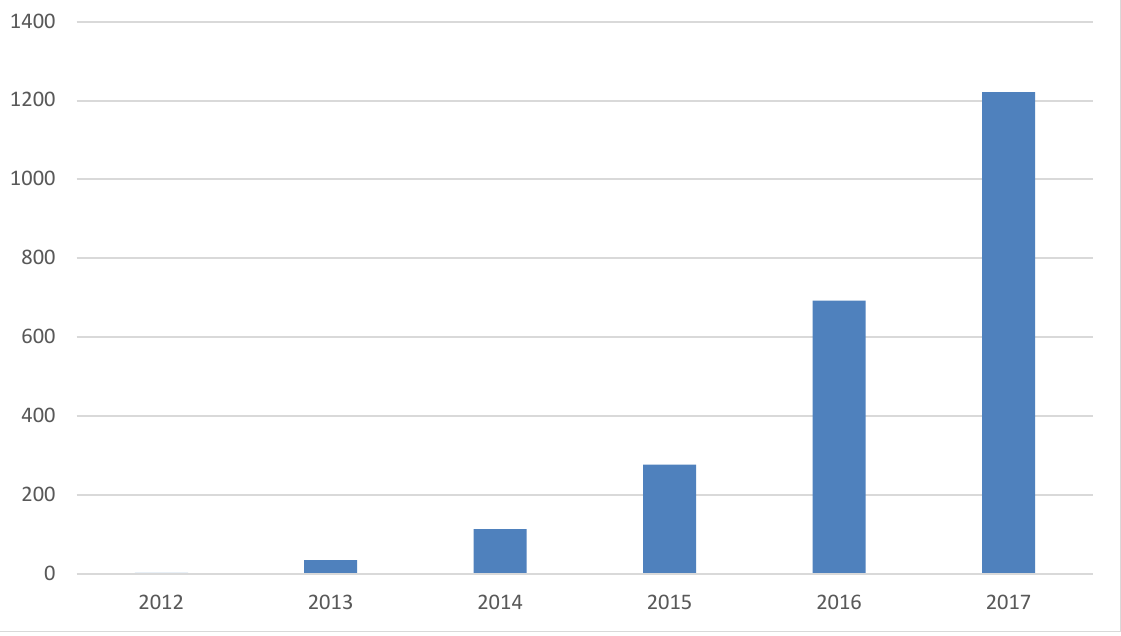
Figure 3. Publications per